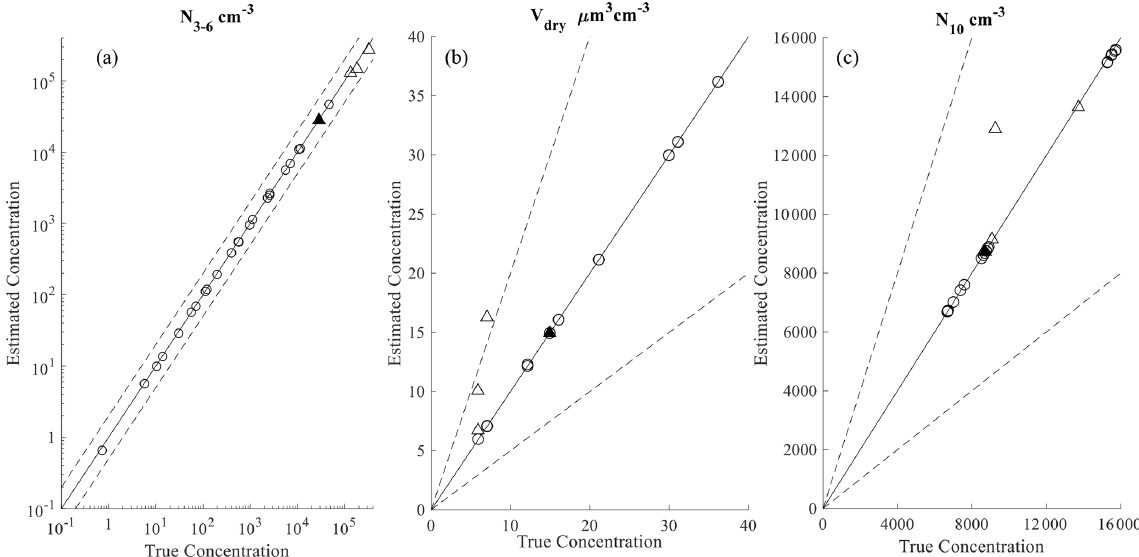
Figure 3. Scatter plots of time-averaged (a) N 3–6 , (b) V dry , and (c) N 10 comparing the inverse modeling estimate and truth from synthetic measurements for each scenario. Circle and triangle markers represent well- and ill-conditioned scenarios, respectively. Open triangles represent scenarios unlikely to be observed with field measurements. The solid line is 1:1, and the dashed lines are 1:2 and